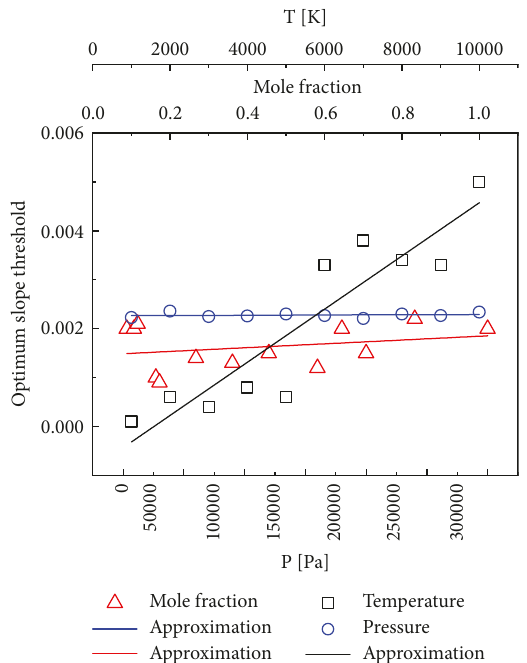
Figure 4: Correlation between the optimum slope threshold and the temperature, pressure, and mole